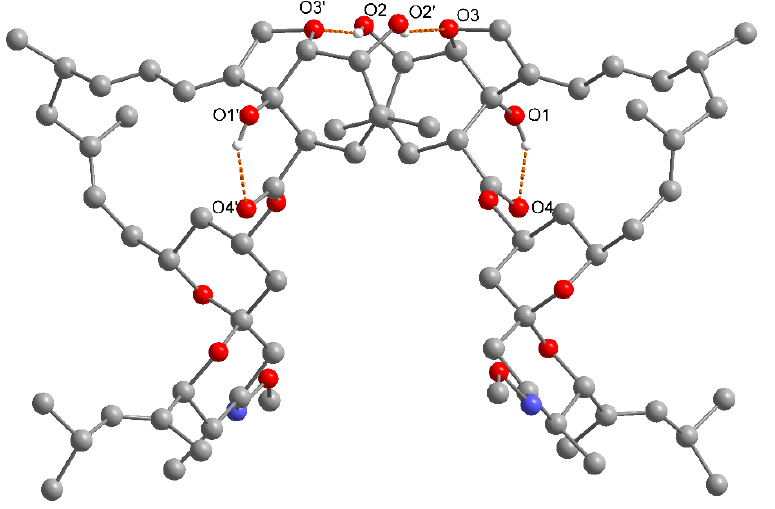
Figure 6. Crystal structure of Moxi·1.5MeNO 2 showing a dimer of two moxidectin molecules. Selected distances O2–O3 ′ 2.863(5) Å, O1–O4 2.759(6) Å. Color code: C, grey; N, blue; O, red; H, white.